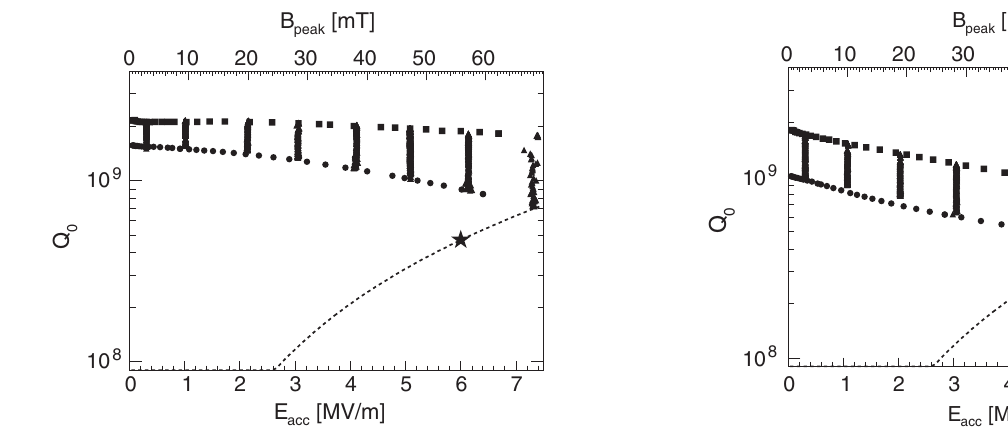
FIG. 2. Quality factor as a function of accelerating gradient for a reduced external magnetic field ( 5 μ T). The circle points show 4.5 K and square ones show 2.4 K. The triangle points are data of intermediate temperature at fixed fields. The dashed line shows 10 W power consumption and the star is the nominal point.